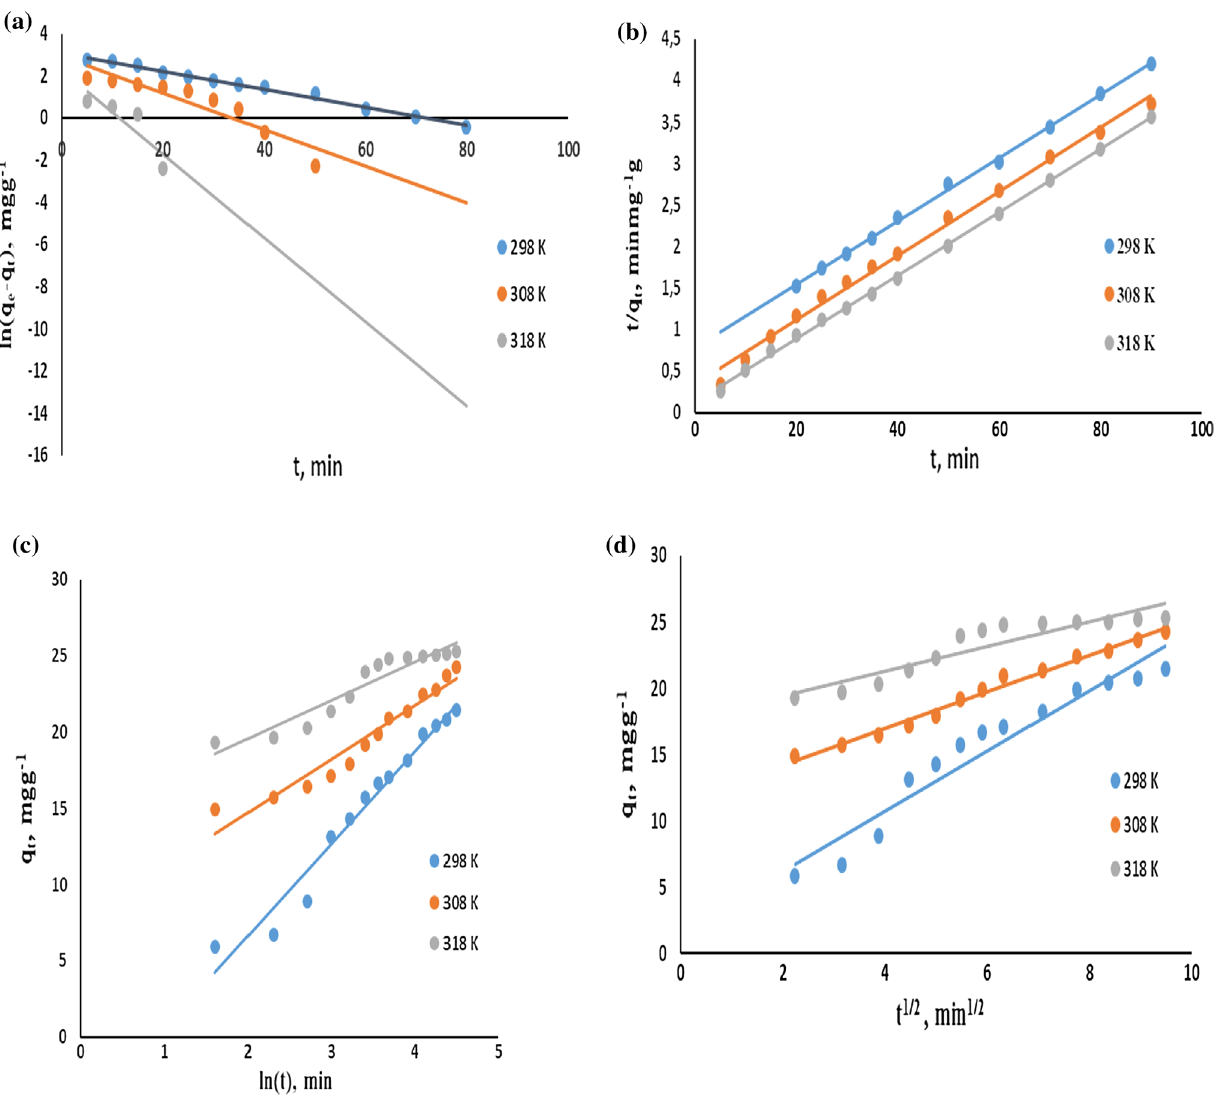
Fig. 7 The temperature effect on the biosorption kinetics ( a PFO kinetics, b PSO kinetics, c EM kinetics, d IDM kinetics; 70 mg L −1 initial MB